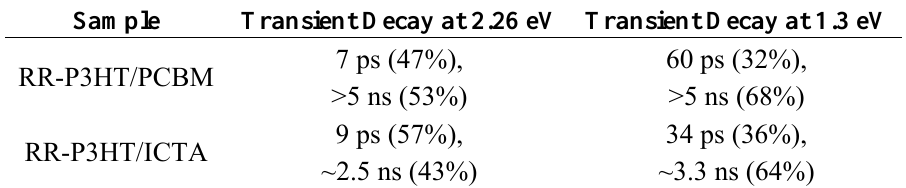
Figure 6. (color on line) ( a ) The transient photomodulation spectrum of RR-P3HT/ICTA blend at t = 1 ps and t = 200 ps, respectively excited at 3.1 eV; the PA bands PB, PA CT are assigned; ( b ) The transient decay of PB (2.26 eV) and the decay of CT 2